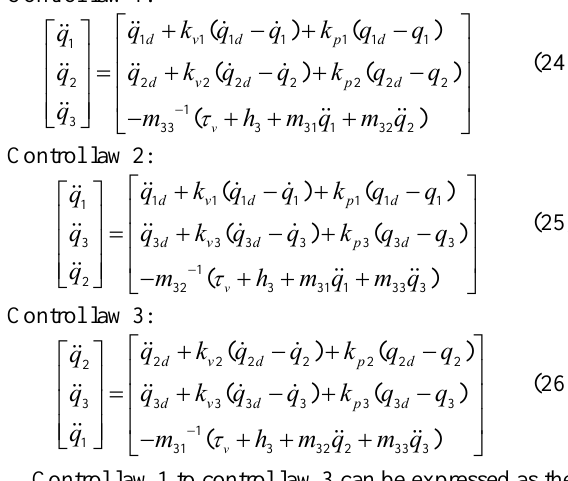
F ig.5 Time responses of joint angles using VSDM